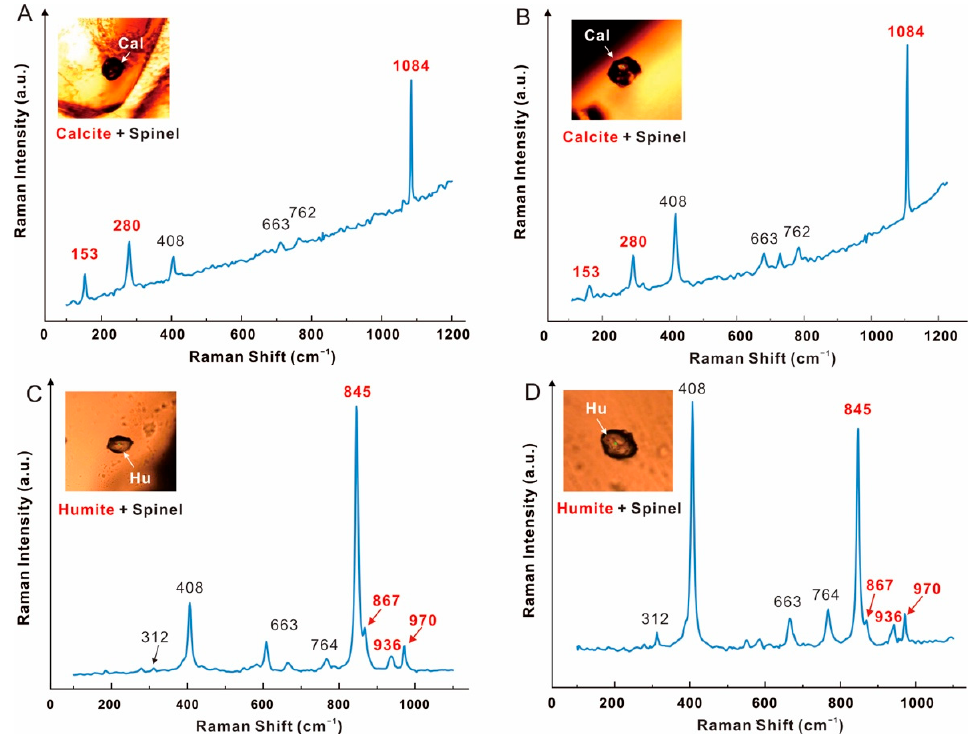
Figure 6. Raman spectra of mineral inclusions in spinel samples from Mogok. Raman spectra showing calcite ( A , B ) inclusions within the orange sample (B-5) and chondrodite ( C , D ) inclusions within the pink sample (B-3).